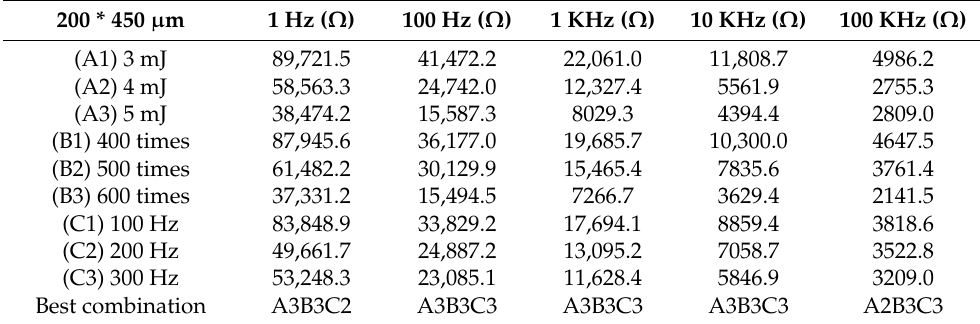
Table 6. Mean value data for 200 * 450 µ m rectangular template.